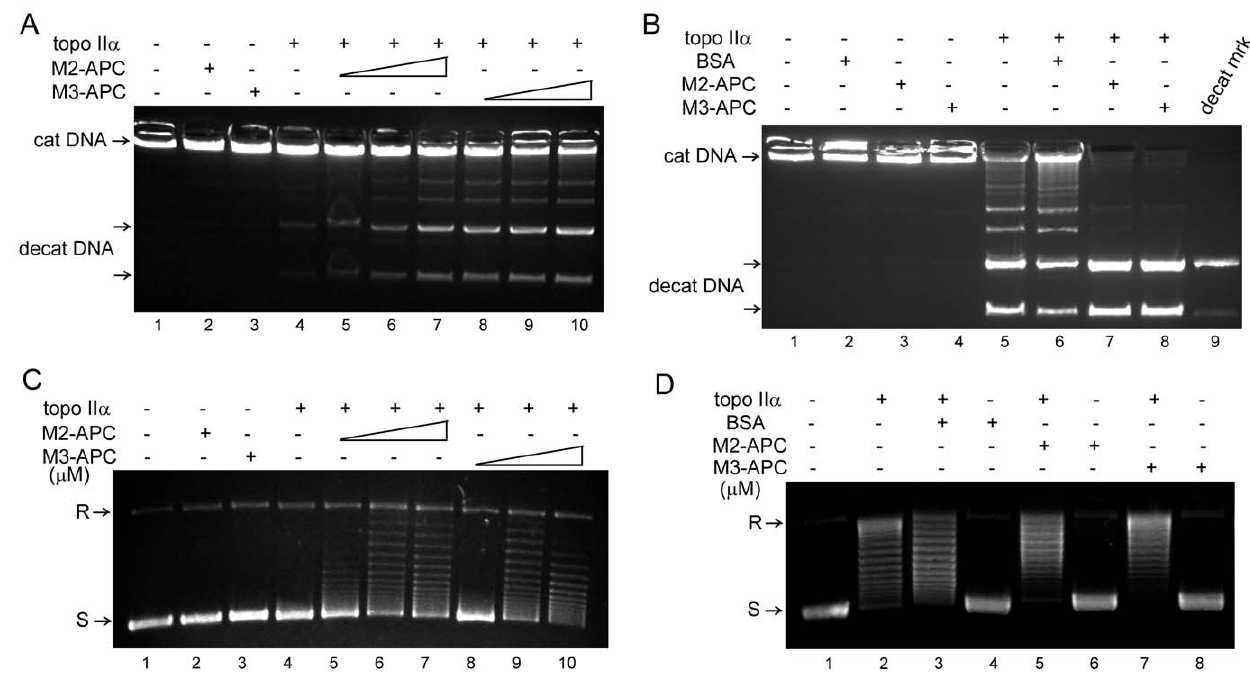
Figure 2. Recombinant M2- and M3-APC each enhance topo II a activity invitro . (A) Purified recombinant human topo II a (0.12 m M) could slightly decatenate catenated DNA (catDNA) (lane 4). Addition of increasing amounts (0.12, 0.24, and 0.6 m M) of purified recombinant M2-APC (amino acid 1000–1326, lanes 5–7) or non-overlapping M3-APC (amino acid 1330–2058, lanes 8–10) resulted in progressively enhanced topo II a DNA decatenation activity. M2-, or M3-APC (0.6 m M) alone did not display decatenation activity in the absence of topo II a (lanes 2 and 3, respectively). (B) Using a higher concentration of topo II a (0.18 m M) that displays slightly more activity in the absence of other proteins, the addition of M2- and M3- APC (0.18 m M) enhances topo II a activity (lanes 7 and 8, respectively). In contrast, BSA (0.18 m M) did not enhance the DNA decatenation activity of topo II a (lane 6). cat DNA, catenated kinetoplast DNA (kDNA); decat DNA, decatenated kDNA. (C) Purified recombinant human topo II a (0.35 m M) could slightly relax supercoiled pBR322 plasmid DNA (lane 4). Addition of increasing amounts (0.35, 0.70, and 1.35 m M) of purified recombinant M2- APC (lanes 5–7) or M3-APC (lanes 8–10) resulted in progressively relaxed plasmids as indicated by slower migrating bands. M2-, or M3-APC (0.70 m M) did not display relaxation activity in the absence of topo II a (lanes 2 and 3, respectively). (D) Under conditions where topo II a displayed